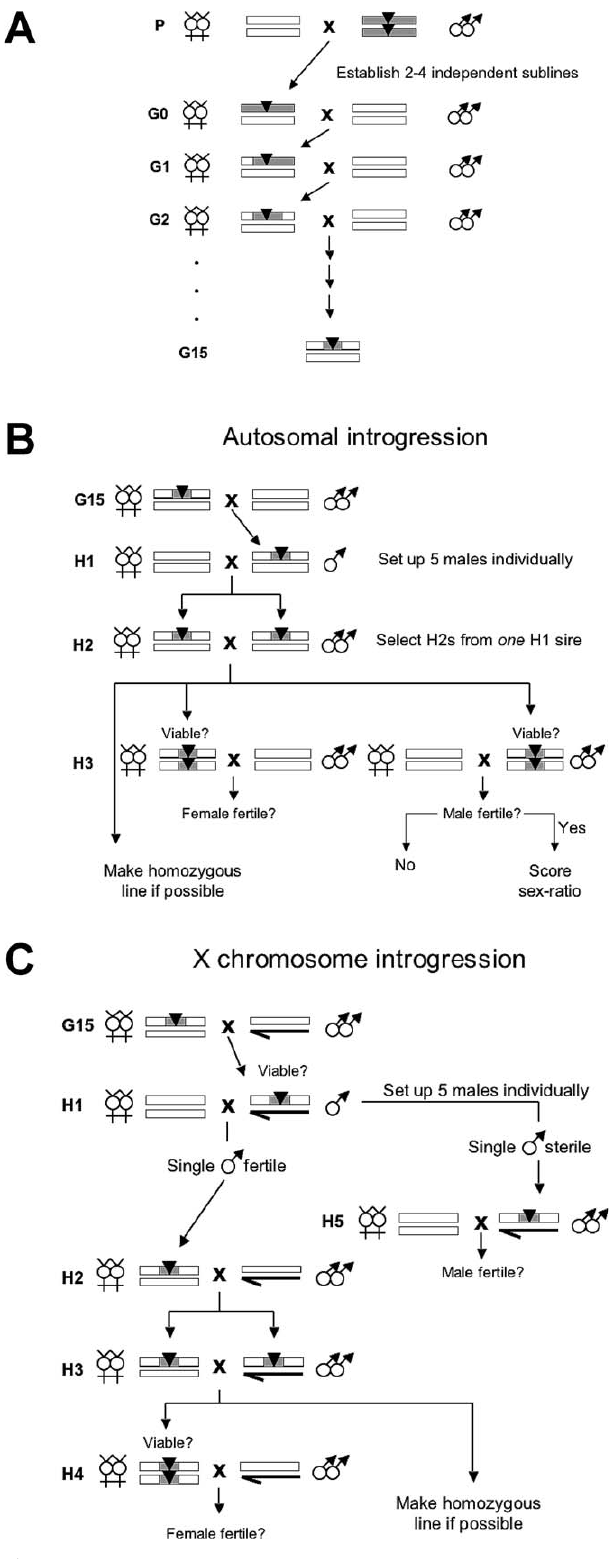
Figure 1. Introgression